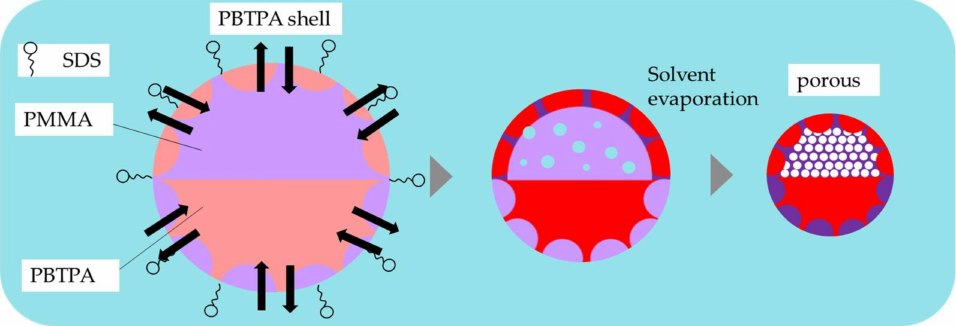
Figure 7. Illustration of the effect of SDS in the formation of PBTPA/PMMA composite